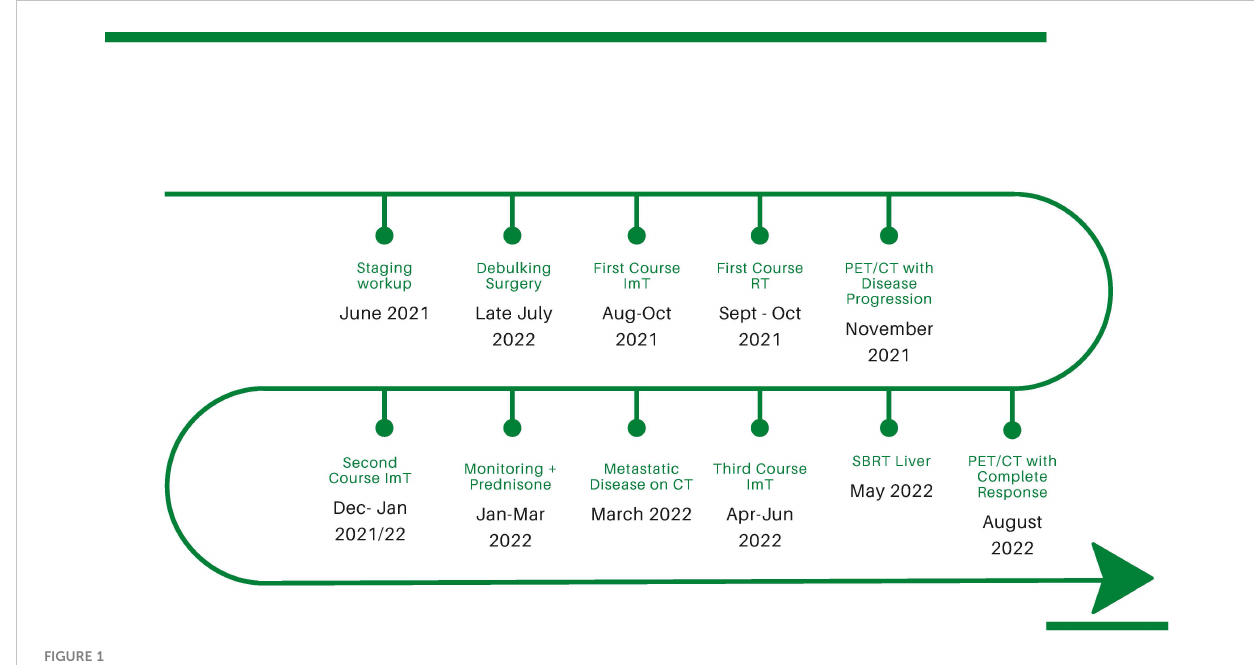
FIGURE 1 Timeline of disease development and treatment